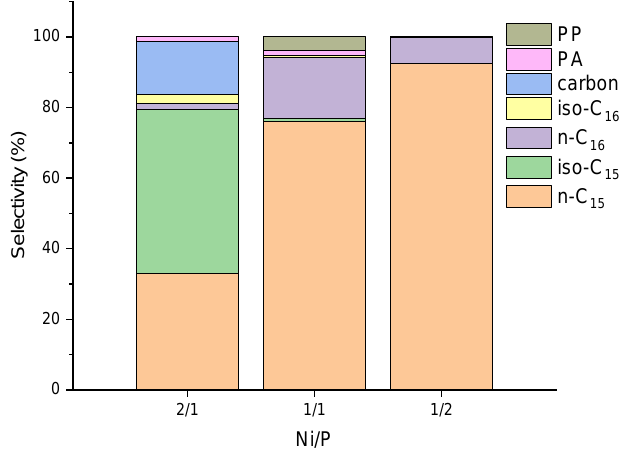
Figure 6. Product distributions after 5 h of reaction (X MP = 100%) in an autoclave over 3 wt.% NiP_A/SAPO-11 samples with different Ni/P molar ratios. 340 °C, 2 MPa, V H2 = 100 mL/min, 500 RPM, m cat = 1.7 g.